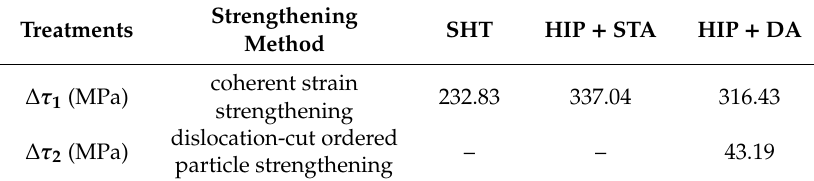
Table 4. The increase in yield strength ( ∆ τ γ (cid:48)(cid:48) ) of the SHT, HIP + STA, and HIP + DA Inconel 718 superalloys [12].